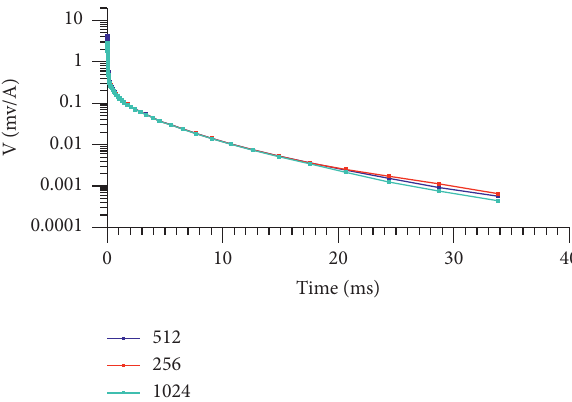
Figure 8: Comparison of V(t)/I attenuation curves with superposition times of 256, 512, and 1024.